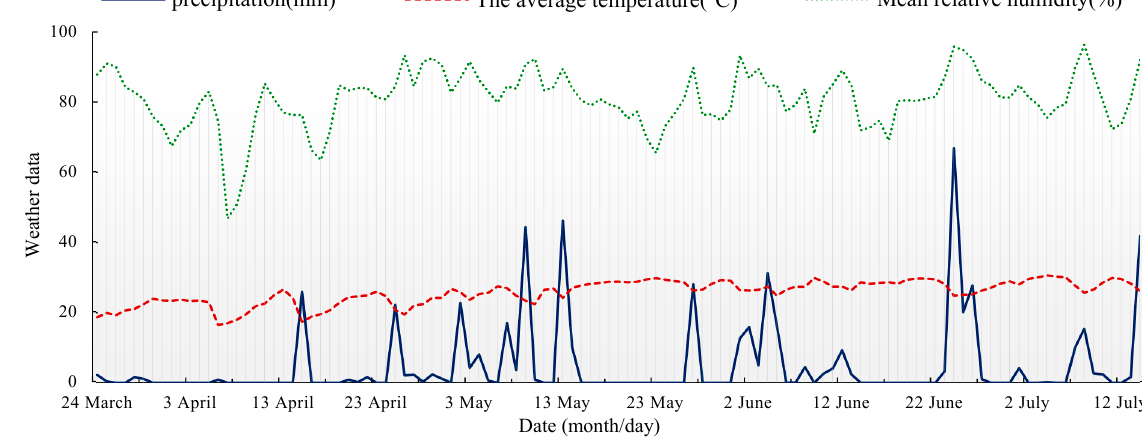
Figure 2. Meteorological data of the experimental field.